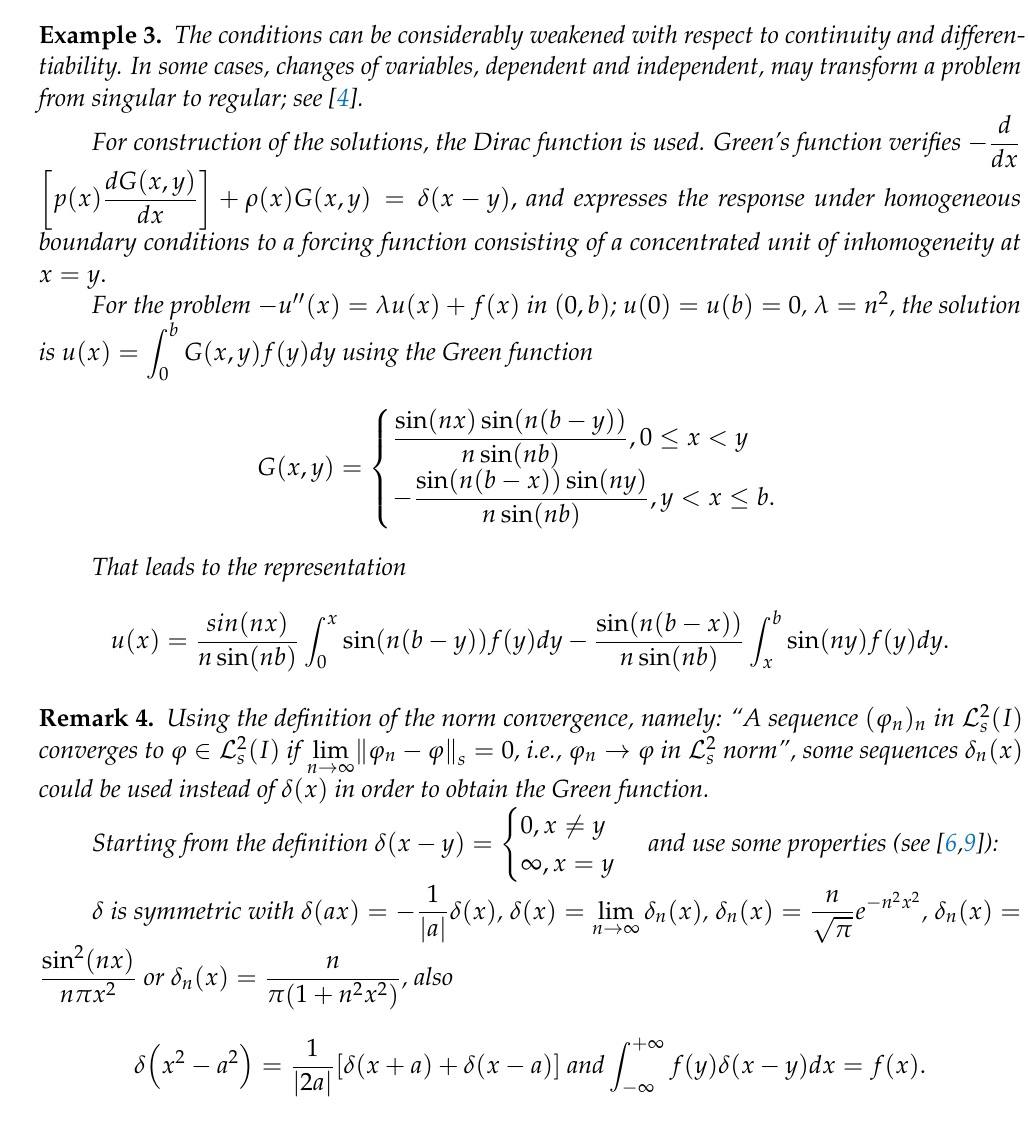
Figure 4. The eigenvalues determination and the corresponding eigenfunctions example